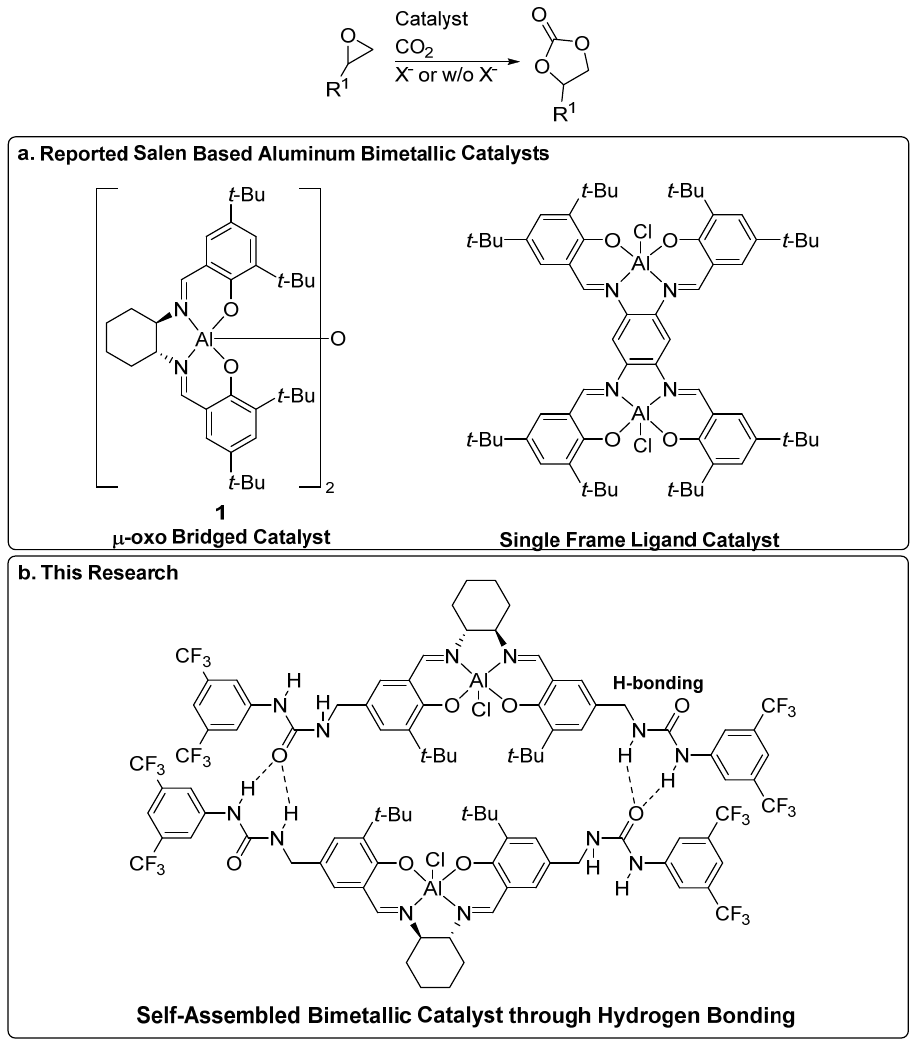
Figure 1. Bimetallic catalysts for cyclic carbonates synthesis. ( a ) Reported bimetallic salen catalysts. ( b ) This research: self-assembled bimetallic catalysts through hydrogen bonding. ( b ) This research: self-assembled bimetallic catalysts through hydrogen